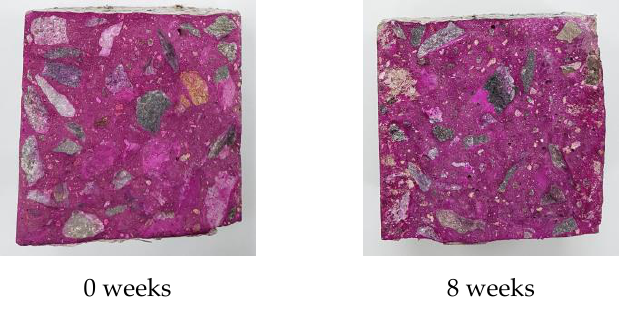
Figure 8. Carbonation test results for NS20.